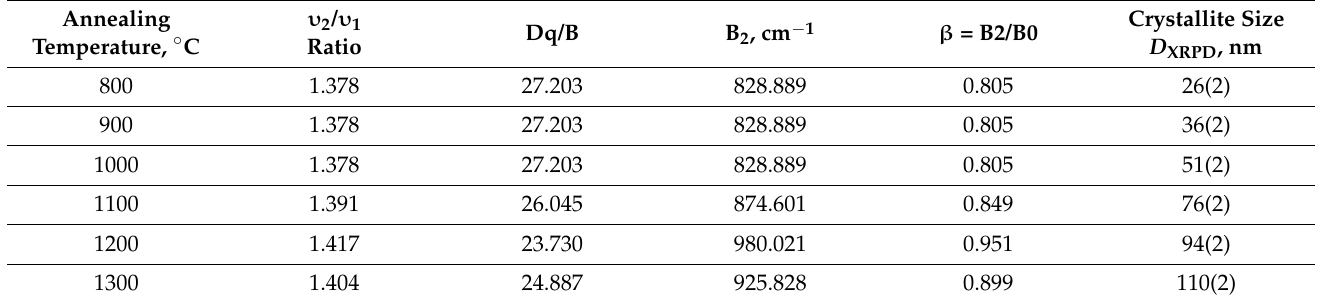
Table 2. Crystal field parameters for YAGG:Cr 3+ nanopowders as a function of annealing temperature calculated with Tanabe-Sugano diagram for a d 3 system.